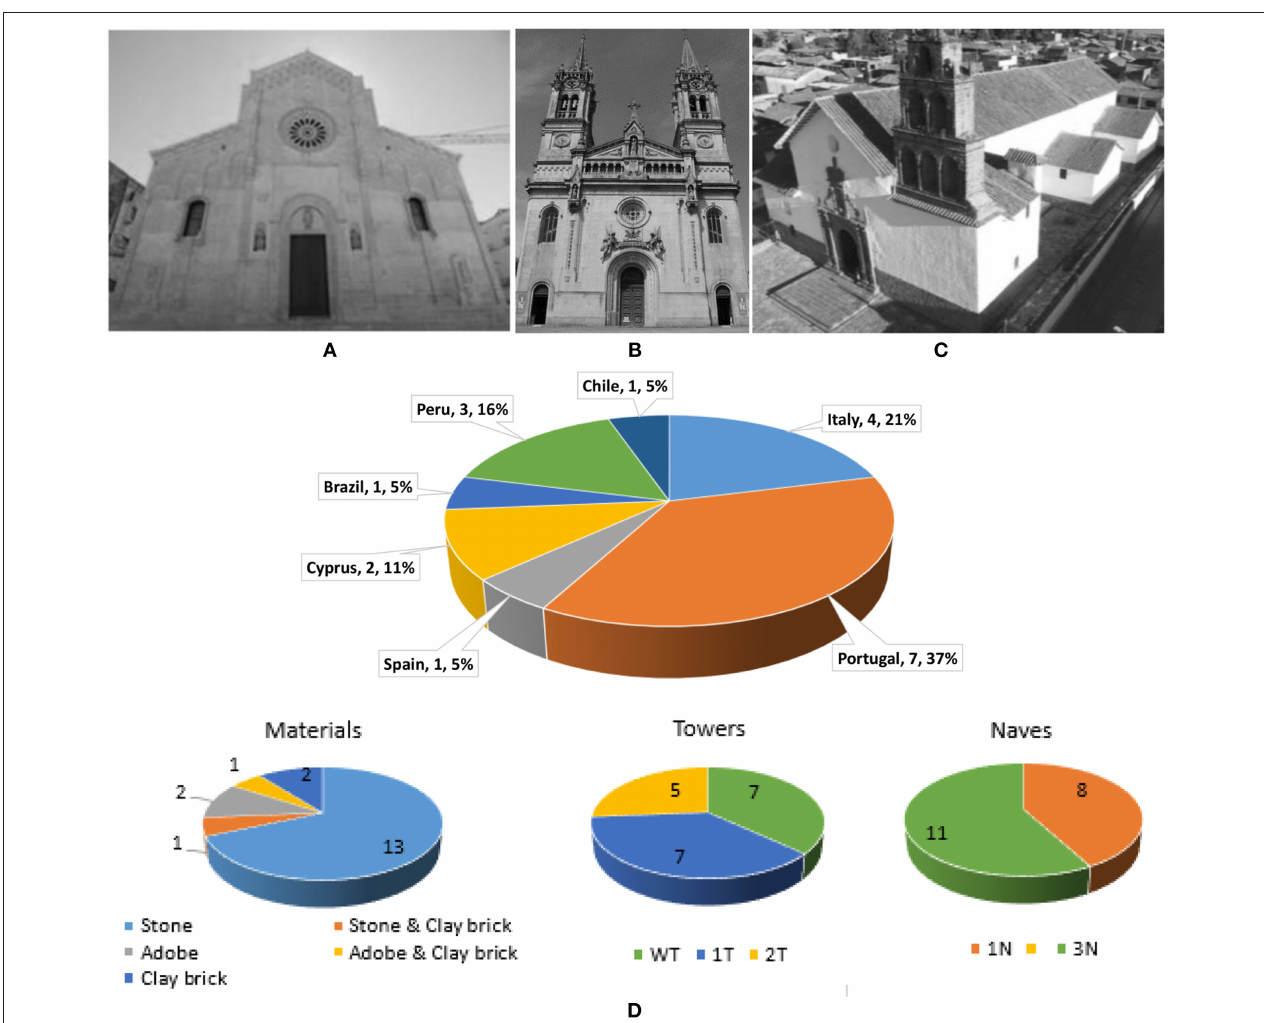
FIGURE 6 | Three examples of masonry churches from the literature review: (A) Matera Cathedral (Italy, Ramirez et al., 2019), (B) Saint Torcato Church (Portugal, Ramos et al., 2013), and (C) San Juan Bautista of Huaro (Perú, Aguilar et al., 2016), and (D) statistical data of the location and structural characteristics of all the studied